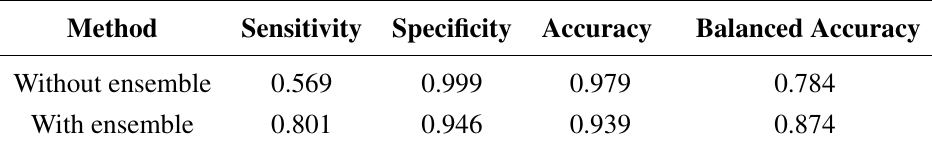
Table 3. Prediction results with or without the ensemble method.